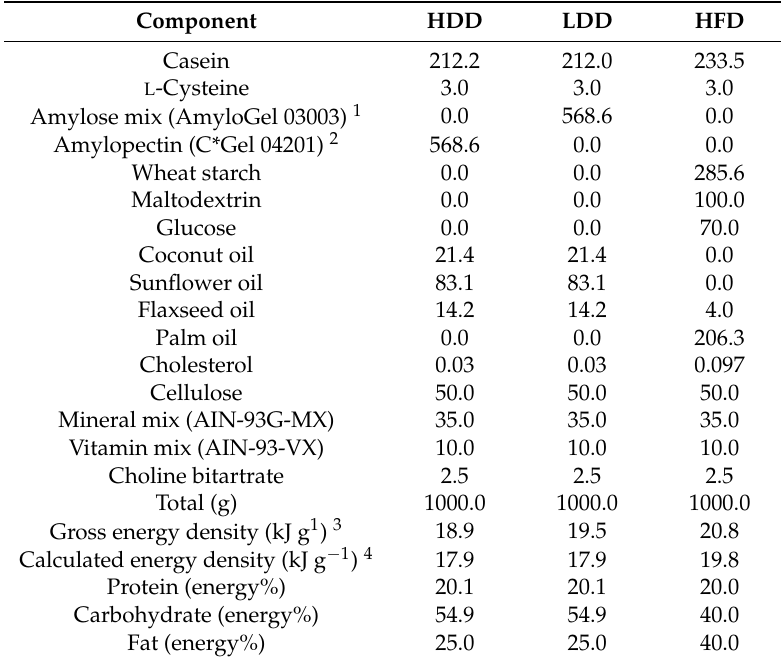
Table 1. Composition of the experimental